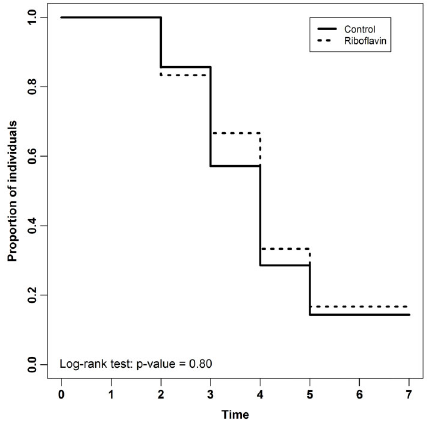
Figure 7. Kaplan-Meier curves for survival analysis of C57BL/6 mice submitted to sepsis induced by cecal ligation and puncture (n= 7 animals per